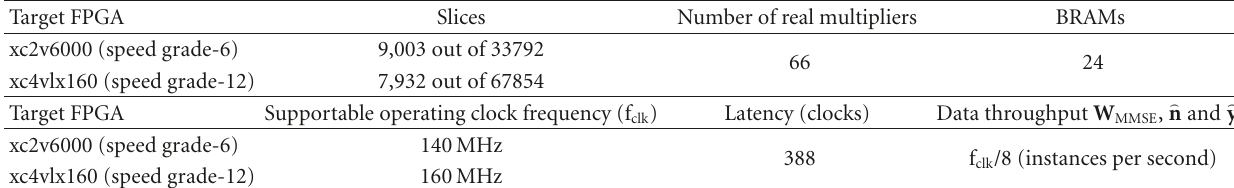
Table 6: Place and route